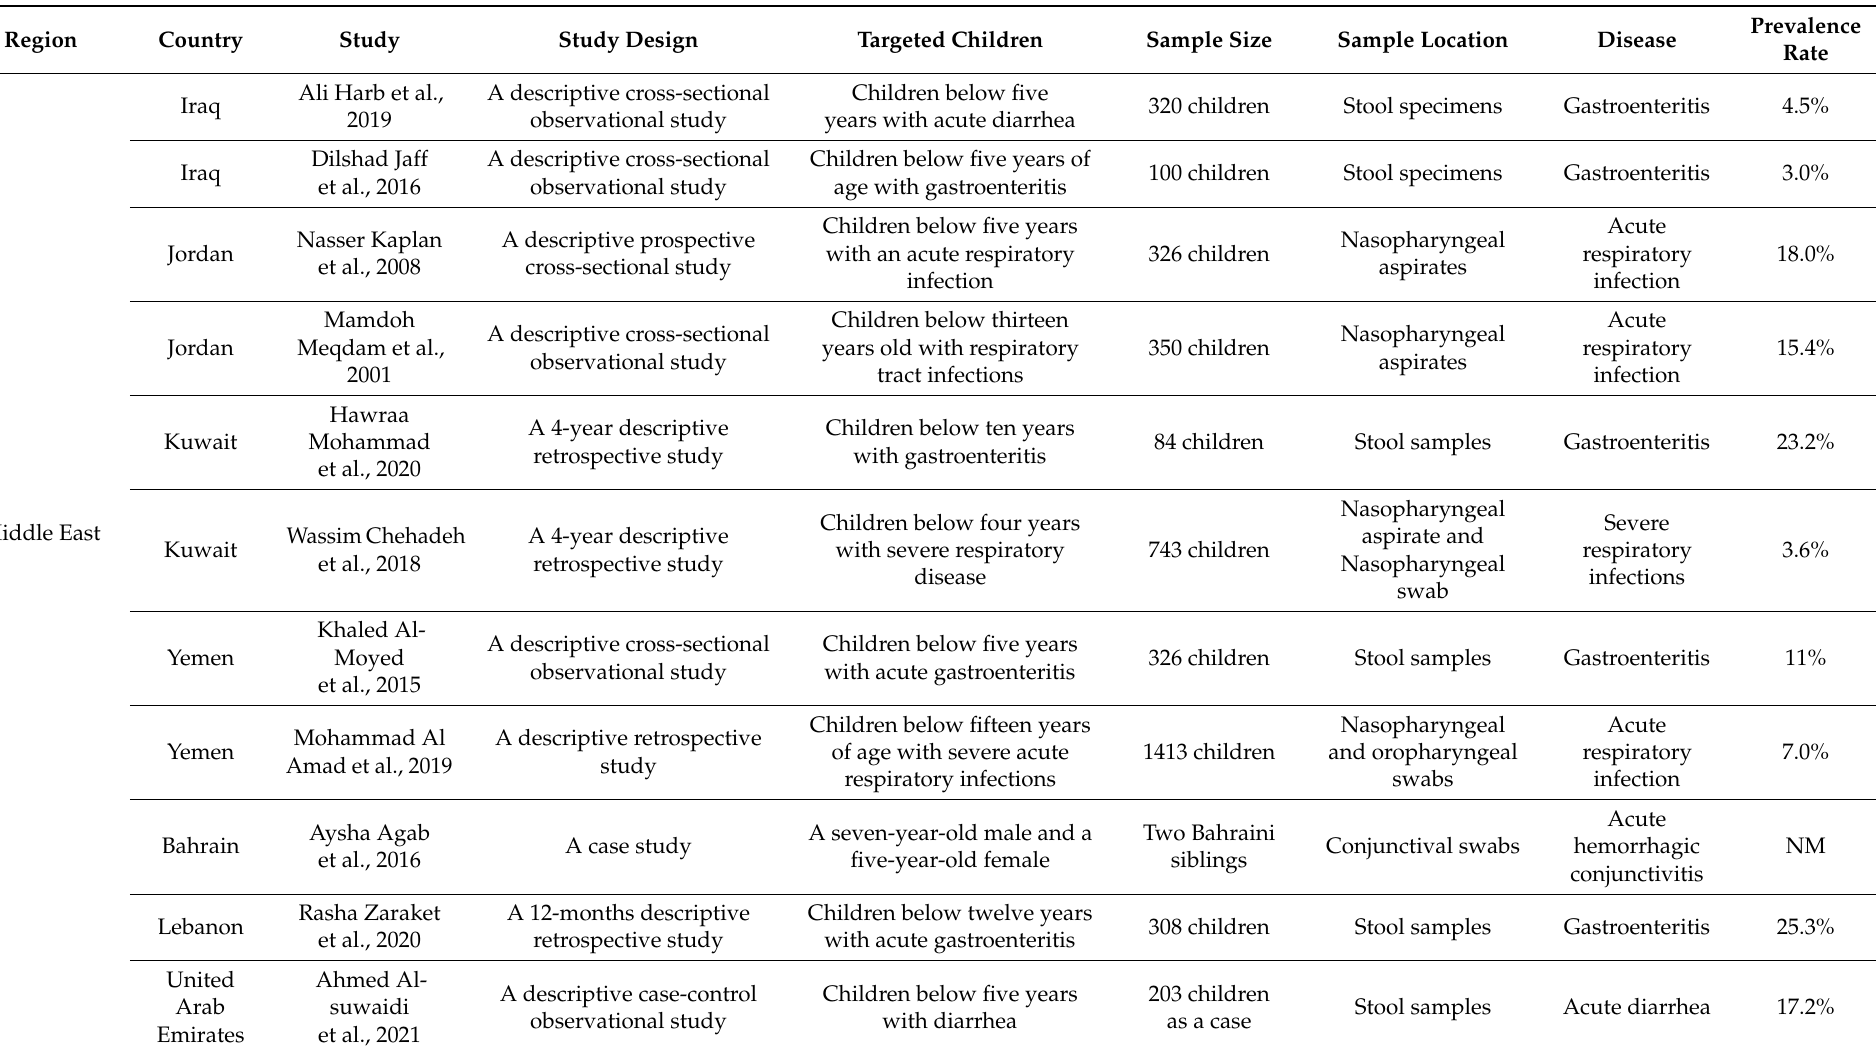
Table 1. Reported HAdV infections among children in the Arab World, particularly in the Middle East and North Africa, up to July